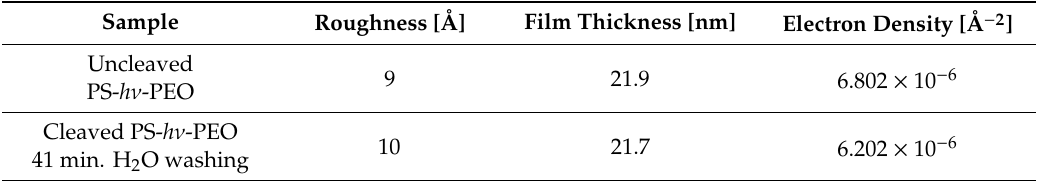
Table 2. XRR data for PS- h ν -PEO thin film obtained from the measured curves in Figure 1c,d. The polymer film was UV cleaved for 4 h and immersed for 41 min. in ultra-pure water.